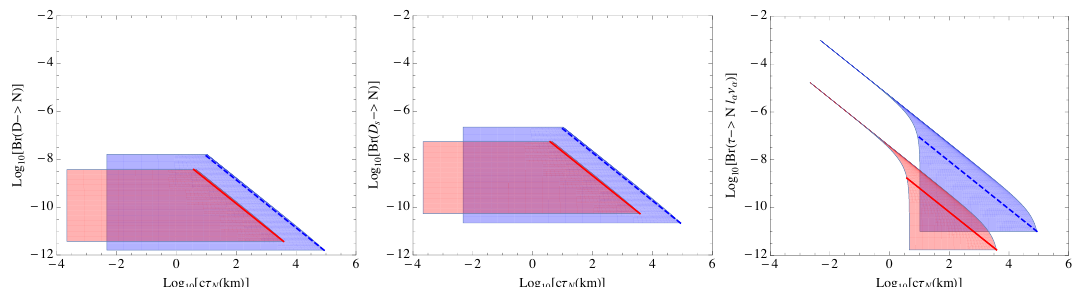
Figure 6 . Allowed ranges for Br( D ! N ) (left panel) and Br( D Br( (cid:28) (cid:6) ! Nl (cid:6) (cid:23) (cid:11) ) (right panel) versus c(cid:28) N , for m N = 0 : 5 GeV (dashed line, blue region) and 1 GeV (cid:11) (solid line, red region). The lines correspond to 10 (cid:0) 10 (cid:20) j U e j 2 = j U (cid:22) j 2 = j U (cid:28) j 2 (cid:20) 10 (cid:0) 6 (10 (cid:0) 7 ) for the lighter (heavier) mass. The ranges correspond to 10 (cid:0) 10 (cid:20) j U e j 2 = j U (cid:22) j 2 (cid:20) 10 (cid:0) 6 (10 (cid:0) 7 ) and 10 (cid:0) 10 (cid:20) j U (cid:28) j 2 (cid:20) 10 (cid:0) 2 (10 (cid:0) 3